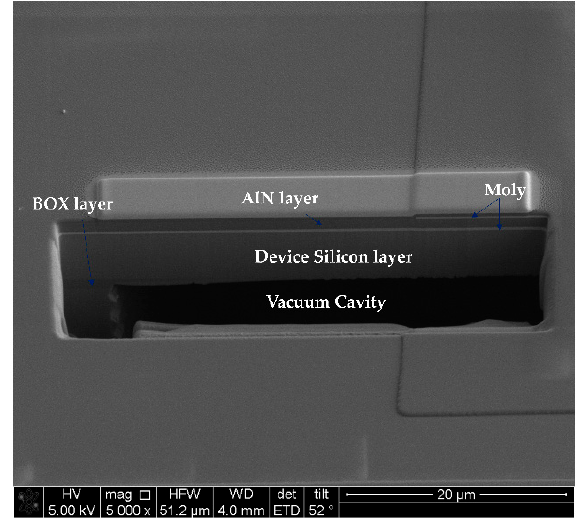
Figure 9. The cross-view SEM image of the device substrate with a vacuum cavity.